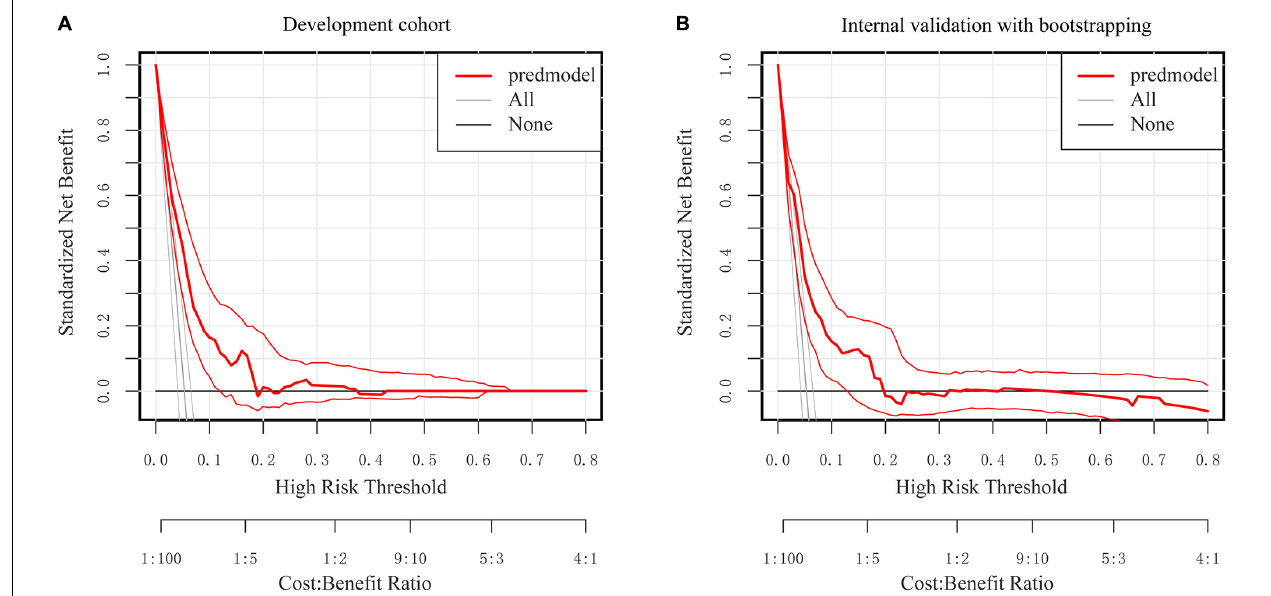
FIGURE 7 | Decision curve analysis for the nomogram. (A) The development Cohort. (B) The internal validation cohort. The Y -axis represents the standardized net benefit. The thick red solid line is the nomogram to predict SSI risk. The thin red solid line represents the 95% credible interval. The black solid line represents the assumption that all patients had no SSI. The gray solid line represents the assumption that all patients had